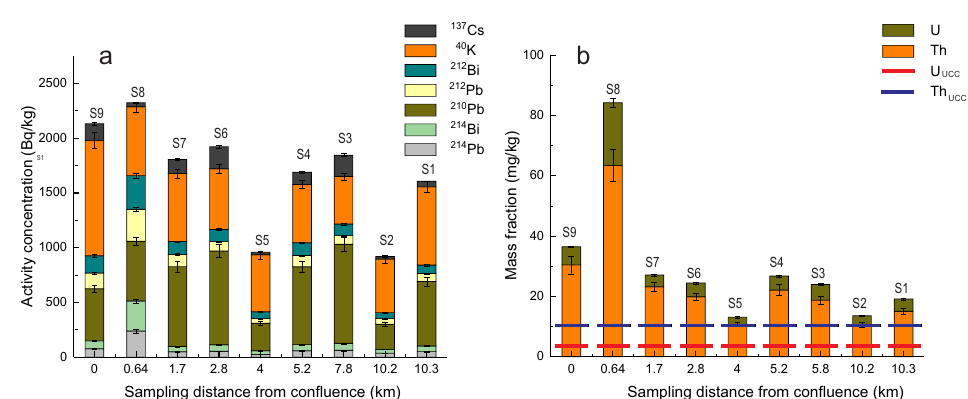
Figure 2. The activity concentration distribution of the main radioactive natural as well as anthro- pogenic isotopes ( a ) and the mass fractions of Th and U ( b ) along the Sioma valley from the confluence with the Varzob river. For comparison, Th and U mass fractions corresponding to the UCC [16] are illustrated